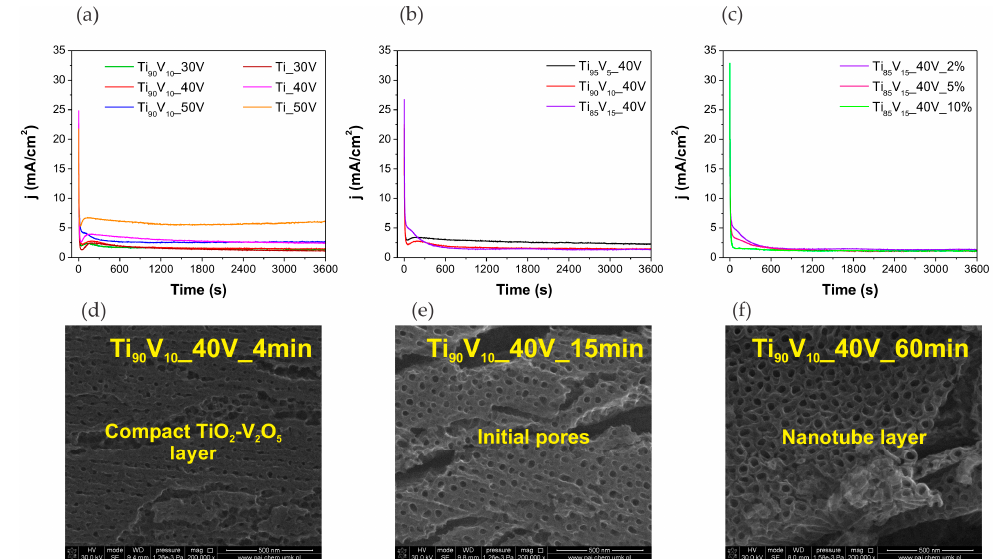
Figure 2. Current density-time curves recorded for the anodization of technical grade Ti foil and Ti-V alloys for the study of ( a ) applied voltage; ( b ) vanadium content in the alloy; and ( c ) water content in the electrolyte. SEM images of Ti 90 V 10 _40V sample anodized during ( d ) 4 min; ( e ) 15 min; and ( f ) 60 min.